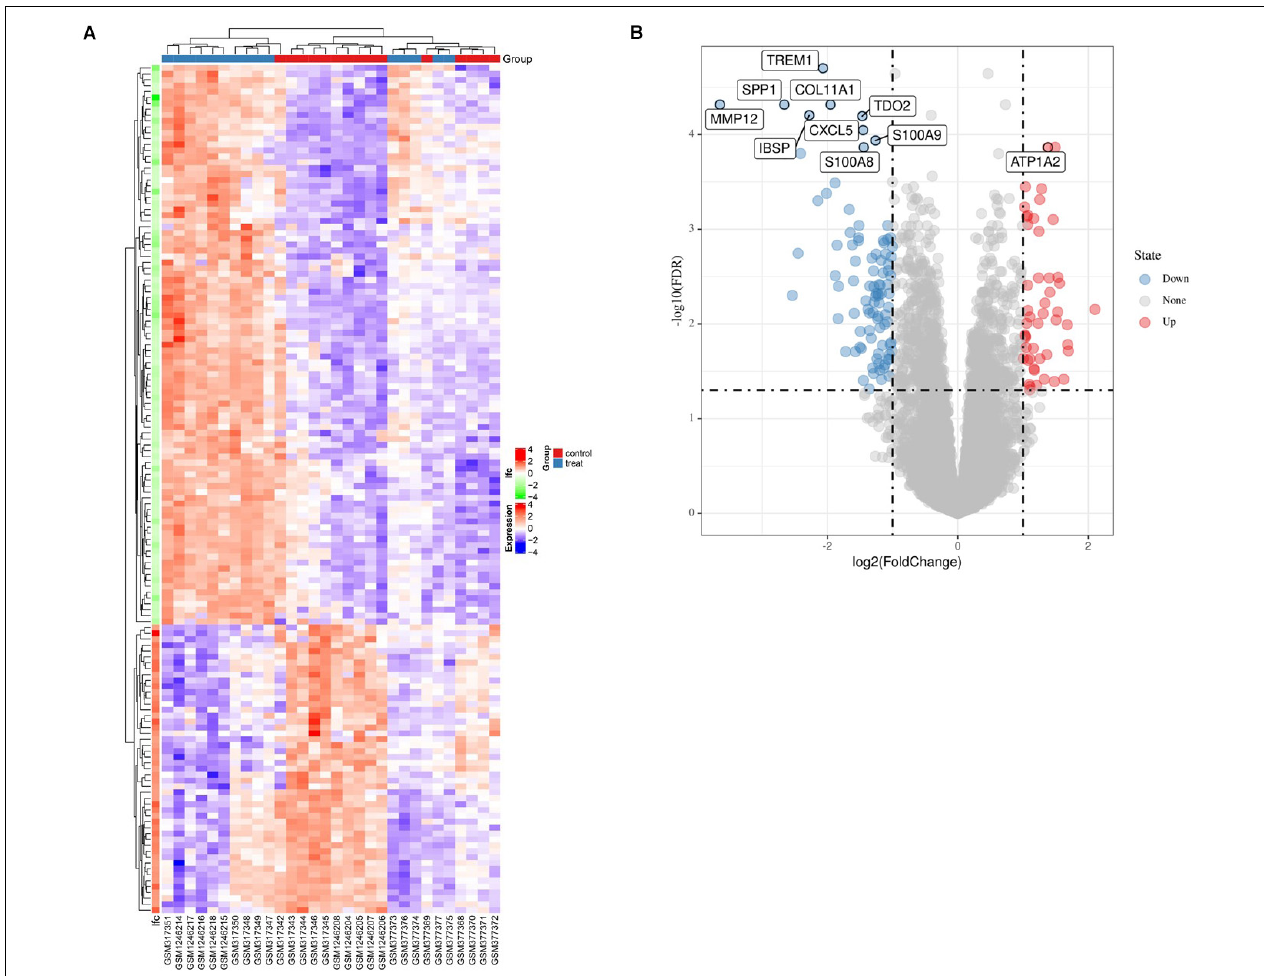
FIGURE 2 | The identification of EDGs. (A) The heat-map of differential expression genes ( P < 0.05, | logFC| > 1). Up-regulated genes were in red and down-regulated genes were in blue. (B) Volcano plot of genes detected in CAVD, red dots represent upregulated genes and blue dots represent downregulated